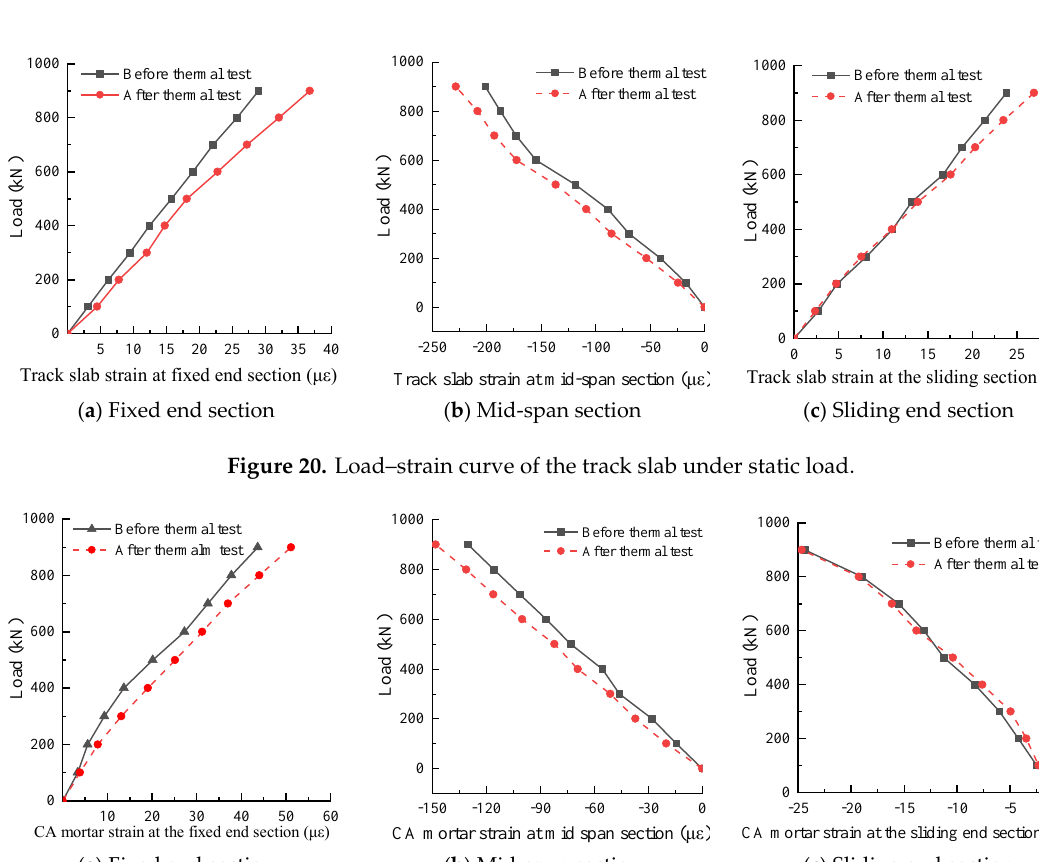
Figure 21. Load–strain curve of the CA mortar under static load.